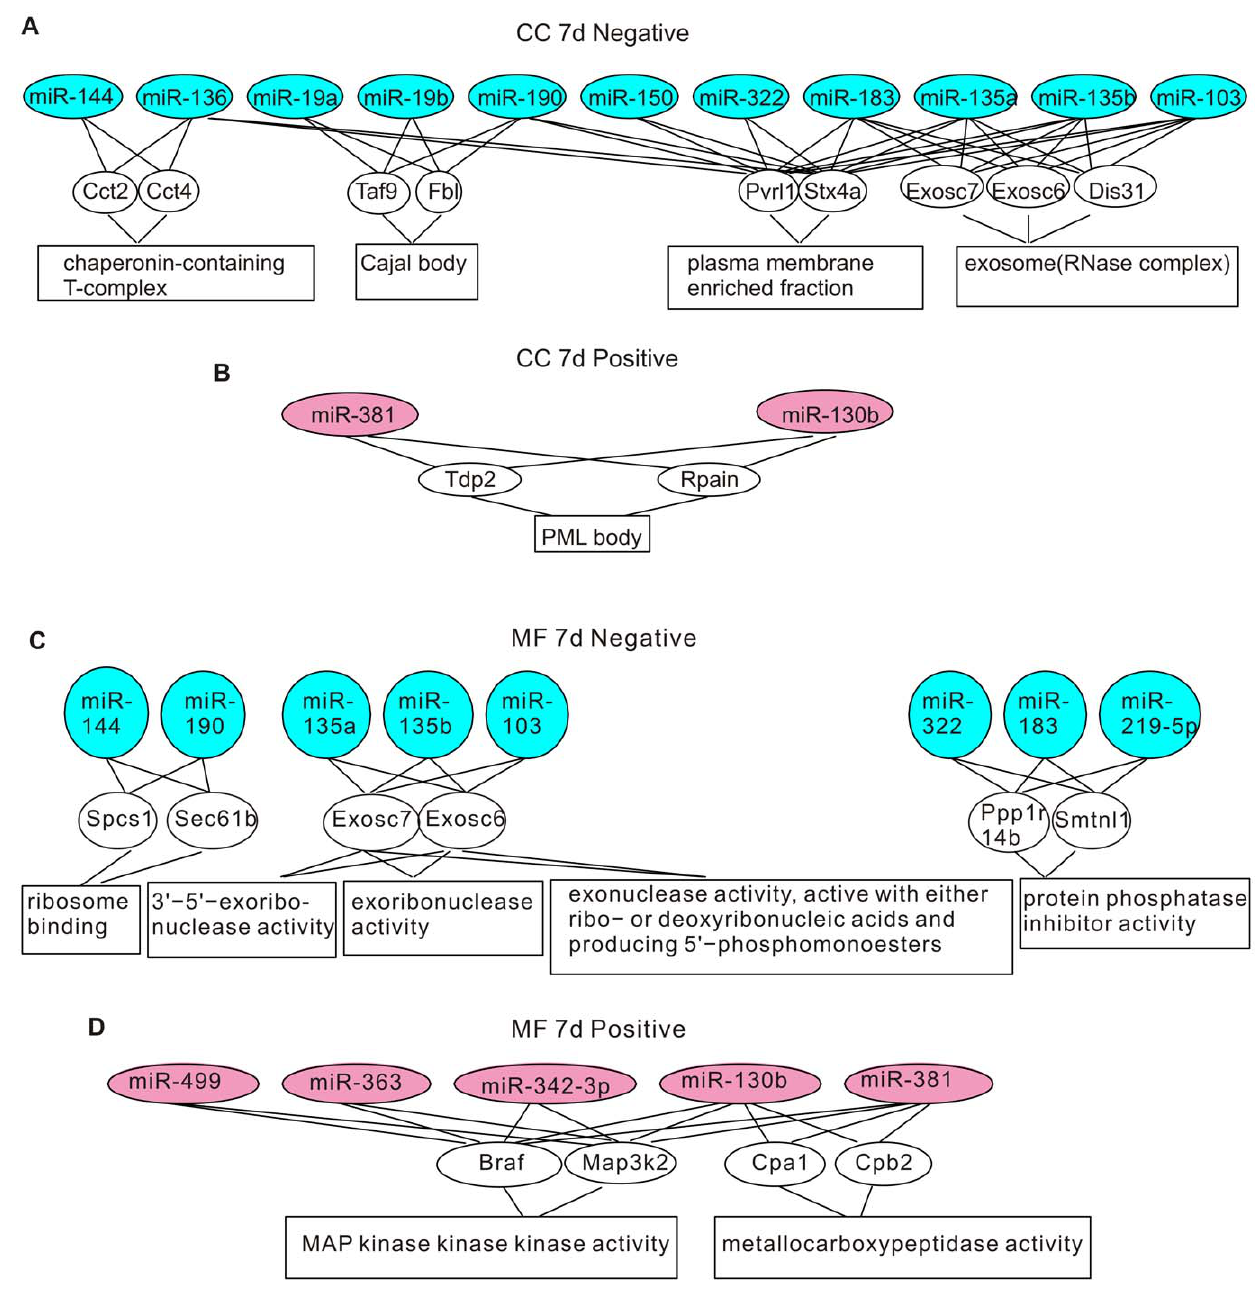
Figure 6. Genes and GO terms in the cellular component and the molecular function ontology that are over-represented by differentially expressed miRNAs at 7 days post-CCI. (A) Genes and GO terms in the cellular component ontology enriched by down-regulated miRNAs. (B) Genes and GO terms in the cellular component ontology enriched by up-regulated miRNAs. (C) Genes and GO terms in the molecular function ontology enriched by down-regulated miRNAs. (D) Genes and GO terms in the molecular function ontology enriched by up-regulated miRNAs.